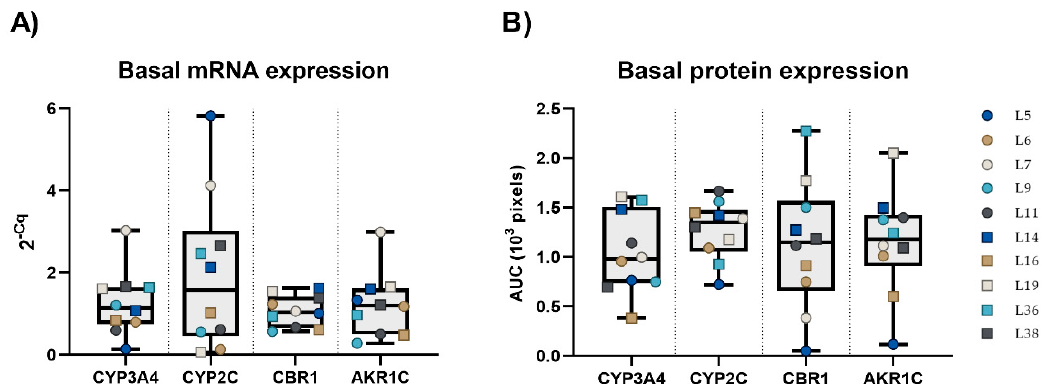
Figure 3. Inter-individual variability in the basal expression of selected mRNAs ( A ) and proteins ( B ) in PCLS from ten patients. The horizontal line represents the median, and whiskers represent the maximum and minimum values.